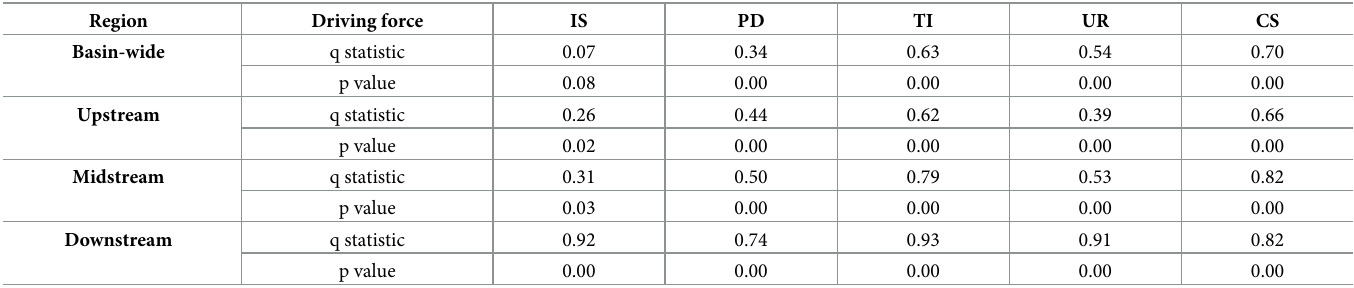
Table 3. The driving force of external factors on the GWF efficiency. Region